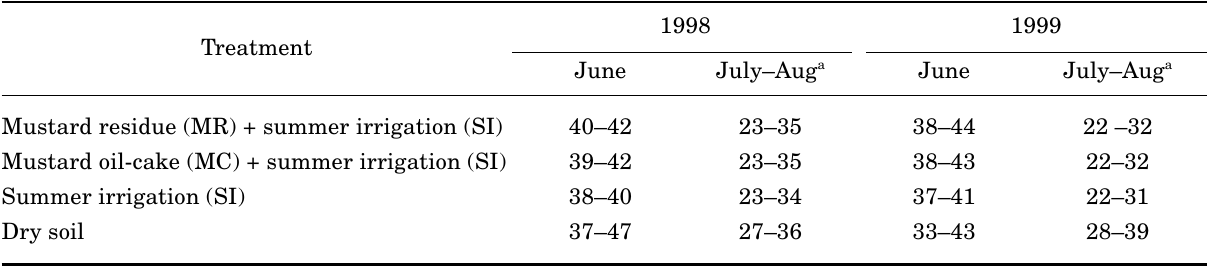
Table 2. Temperature ranges ( ° C) after soil amendment and summer